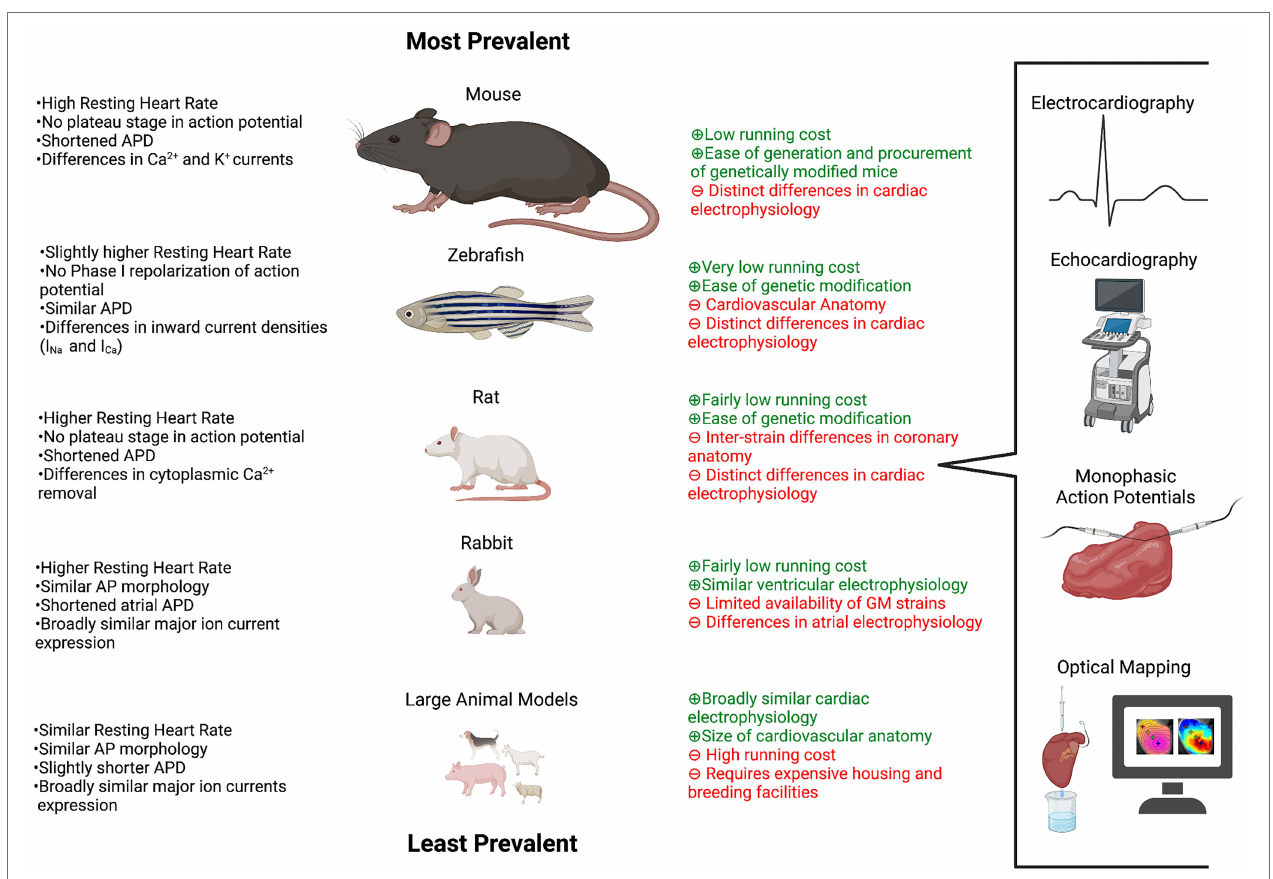
FIGURE 1 | In vivo models used in cardiac arrhythmia and heart failure research. An outline of the animals used in arrhythmia and heart failure research, their electrophysiological similarities and differences in relation to humans, the advantages (green) and limitations (red) of their use and the techniques most commonly used in their evaluation. The size of the animal represents the prevalence of their use. Created with